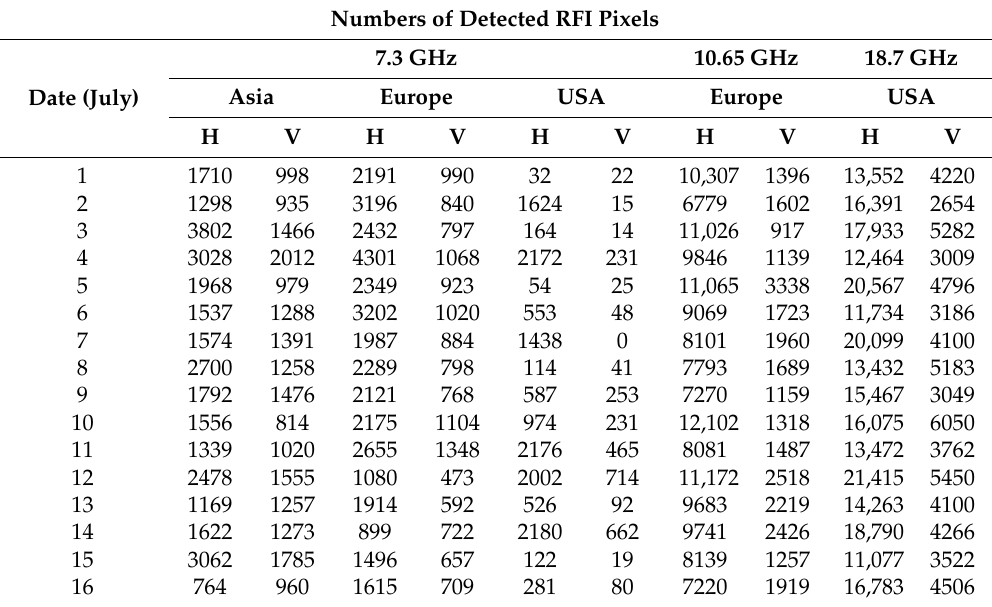
Table 2. Numbers of detected RFI